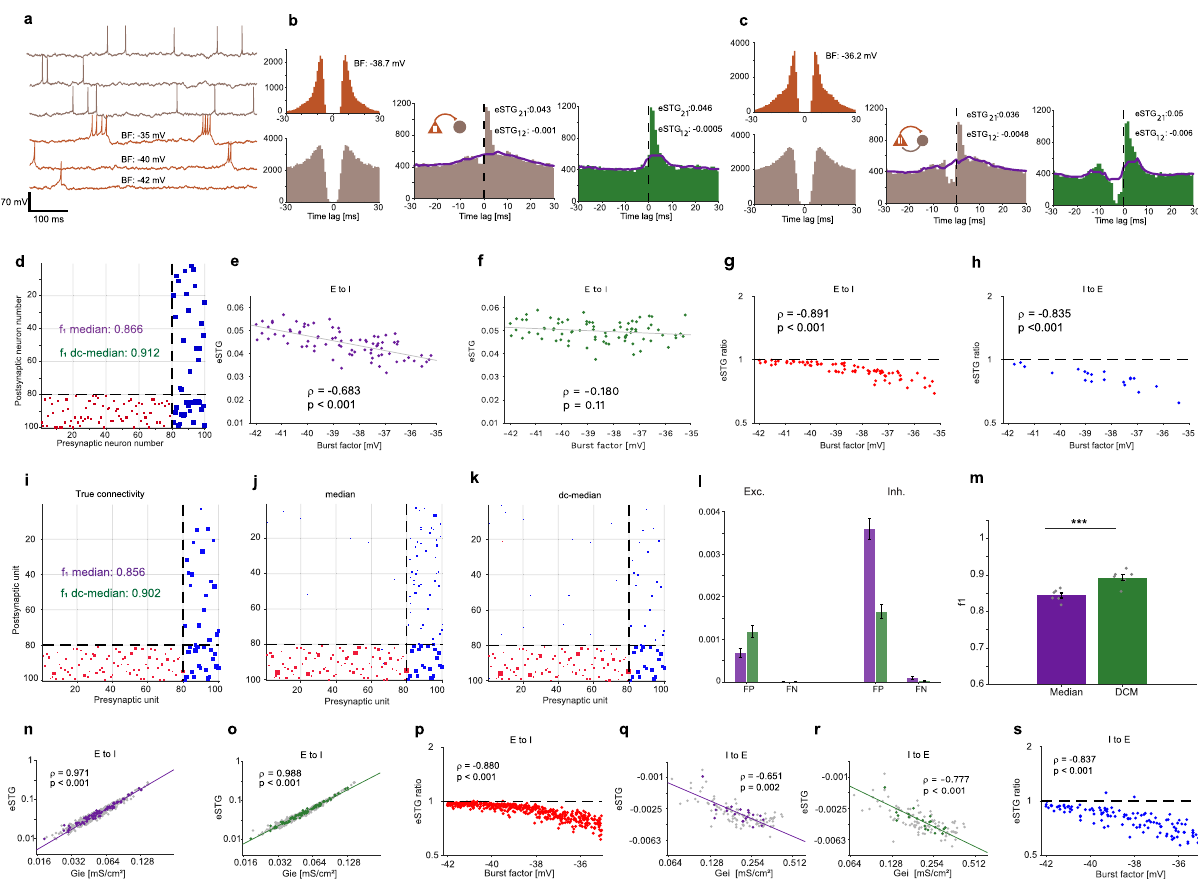
Fig. 5 Deconvolution improves connection quanti fi cation and detection in networks of conductance-based CA1 model neurons. a Traces show example membrane potentials of six simultaneously-simulated cells. Gray, inhibitory neurons (I-cells); orange, excitatory neurons (E-cells), sorted according to burstiness, quanti fi ed by the burst factor (BF). b , c Example ACHs and CCHs for two E-to-I cell pairs. b A pair with feedforward excitation (Gie = 0.055 mS/cm 2 , Gei = 0 mS/cm 2 ). c A pair with reciprocal excitation and inhibition (Gie = 0.055 mS/cm 2 , Gei = 0.25 mS/cm 2 ). Both pairs were embedded in the same hundred-cell network; in both cases, deconvolution increased the eSTGs. d – h A network of 100 neurons (80/20 E/I cells) with fi xed connectivity strengths was simulated. E-cell BFs were drawn uniformly from the [ − 42 − 35] mV range. d Hinton diagram of network connectivity. Red/blue squares represent excitatory/inhibitory connections, and square size is proportional to connectivity strength. Dashed lines separate E- and I-cells. e , f eSTGs of n = 80 fi xed E-to-I connections vs. BF using median fi ltering without ( e ) and with ( f ) deconvolution. Only eSTGs estimated without deconvolution are correlated with the BF. g , h eSTG ratios for n = 80 E-to-I ( g ) and for n = 20 I-to-E ( h ) connections. i – s Six different hundred-neuron networks were simulated with synaptic conductance values drawn randomly from log-normal distributions. Other details were the same as in ( d – h ). i – k Hinton diagrams for one of the networks. l FP and FN rates were computed for all datasets using median fi ltering without (purple bars) and with deconvolution (green bars). Fractions are out of a population of {Exc. FP: n = 59,520; Exc. FN: n = 480; Inh. FP: n = 59,760; Inh. FN: n = 240} connections. Error bars depict SEM. m Mean f 1 scores for all datasets and connection types. Error bars, SEM. n = 6 networks. p < 0.001, bootstrap test, n = 3500 iterations. n , o eSTGs for E-to-I connections plotted against true connectivity magnitude (the excitatory conductance, Gie). Colored dots depict n = 80 connections from the dataset shown in ( i ), and gray dots depict n = 400 connections from other datasets. The best linear fi t (solid line) and Spearman ’ s correlation coef fi cient are shown for the colored dots. p eSTG ratios for n = 480 E-to-I connections of all datasets. eSTG ratios are negatively correlated with BF. q , r Same as n , o , for I-to-E connections. Colored dots depict n = 20 connections from the dataset shown in ( i ), and gray dots depict n = 100 connections from other datasets. s eSTG ratios for n = 120 I-to-E connections of all datasets. Ratios are negatively correlated with